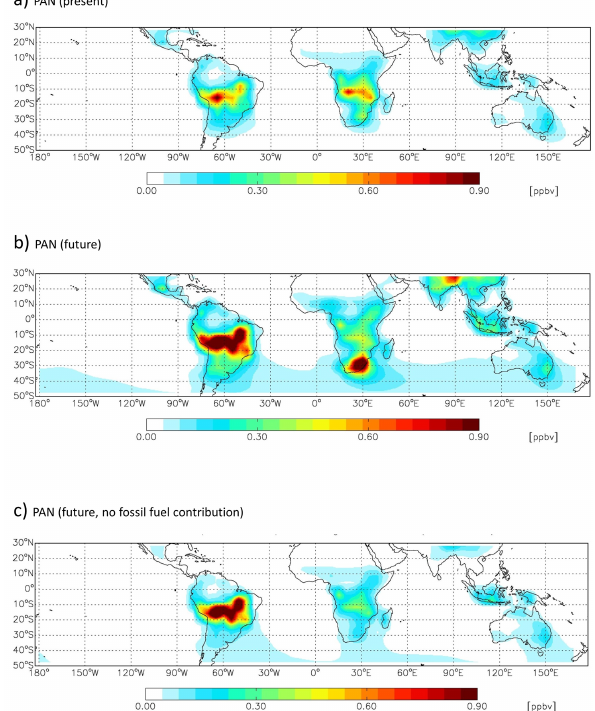
Figure 9. Lower tropospheric PAN distribution (ppb) over south- ern Africa, South America, the remote SAO and Indian Ocean in present September (a) , future September (b) and that excluding the fossil fuel contribution (c) .